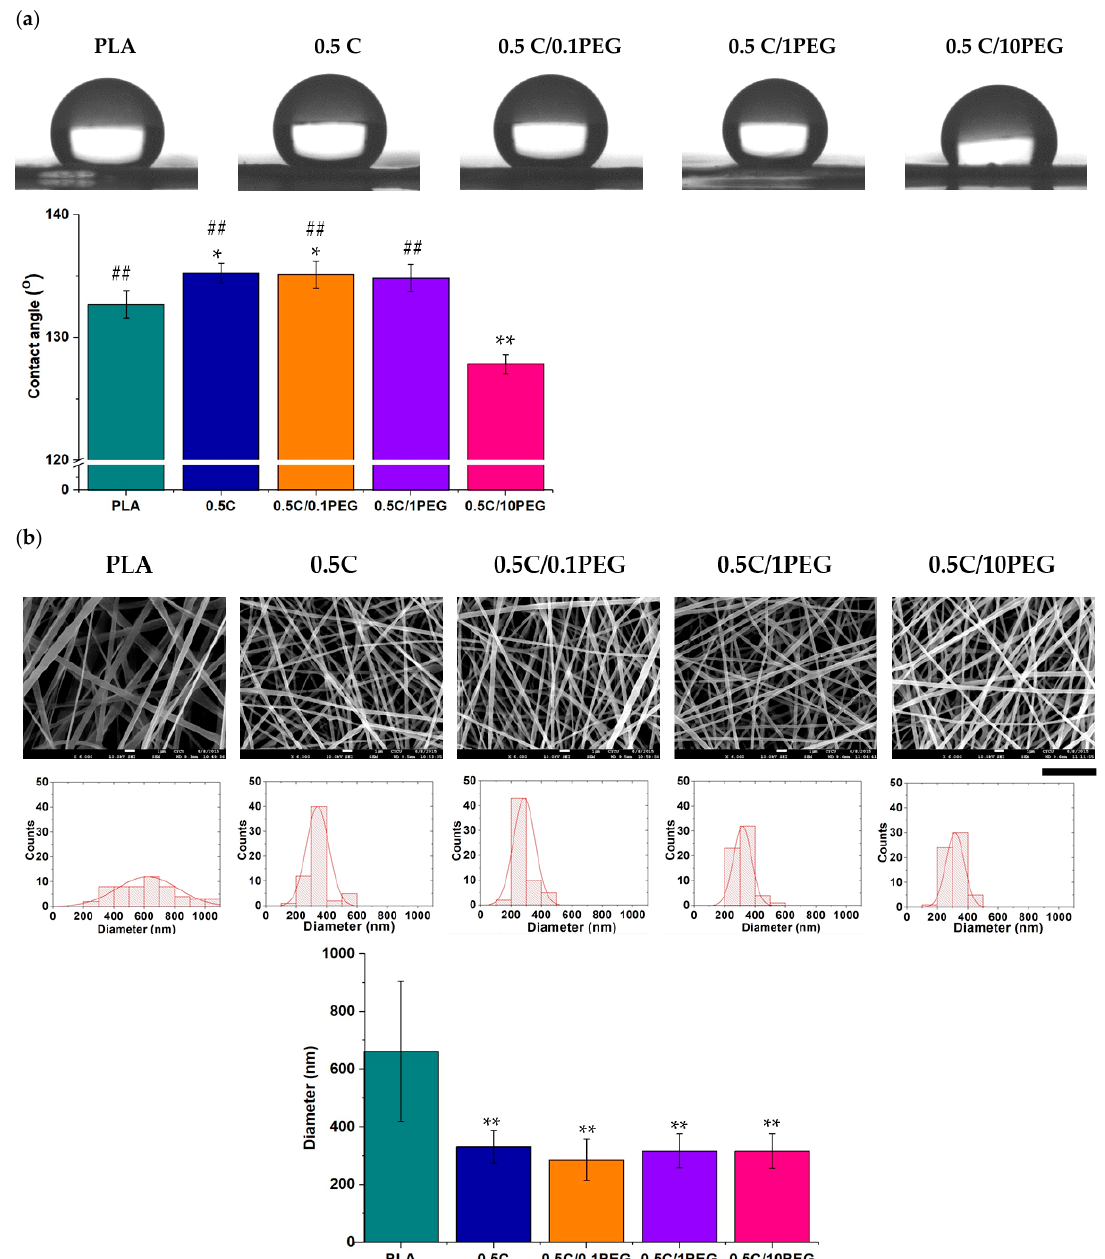
Figure 2. Characteristics of PEG-containing nanofibers: ( a ) the hydrophobicity of the nanofibers was evaluated by water contact analysis. (*: p < 0.05, **: p < 0.01 compared to the pristine PLA group; ##: p < 0.01 compared to the 0.5 C/10PEG group) ( b ) The morphology and size distribution of nanofibers were examined by SEM analysis. (scale bar = 5 μ m) (**: p < 0.01 compared to the pristine PLA group).